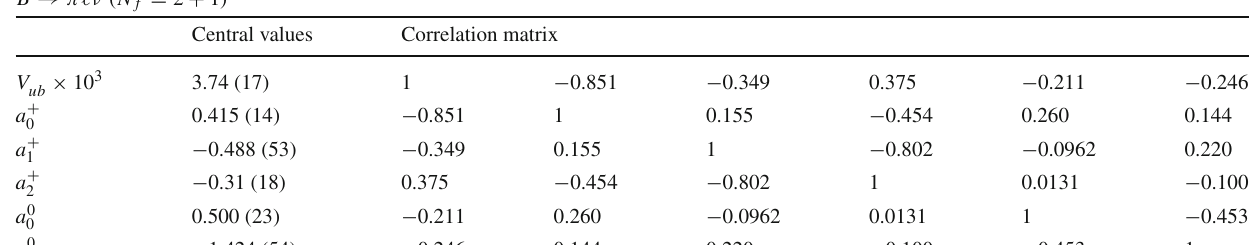
Table 57 | V ub | , coefficients for the N + = N 0 = N T = 3 z -expansion of the B → π form factors f + and f 0 , and their correlation matrix. The chi-square per degree of freedom is χ 2 / dof = 78 . 7 / 56 = 1 . 41 and the errorson the fit parameters have been rescaled by